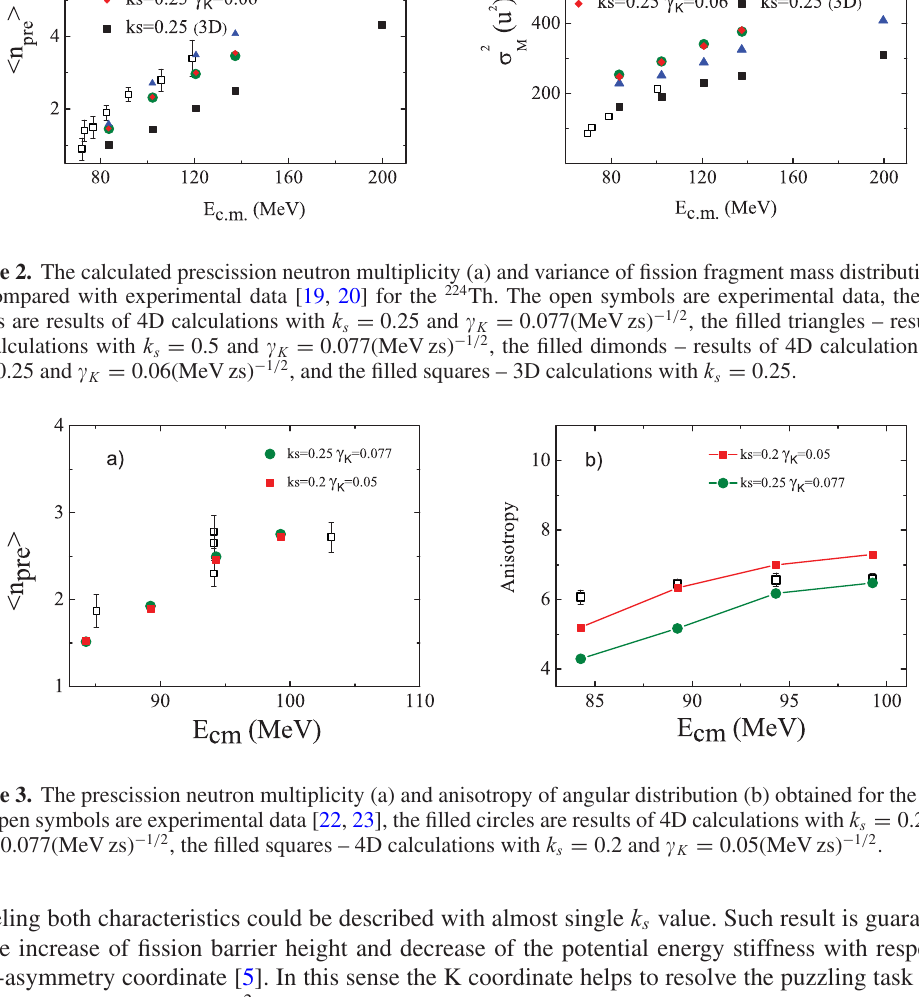
= 0.2 and (cid:1) = 0.05(MeVzs) − 1 / 2 s K